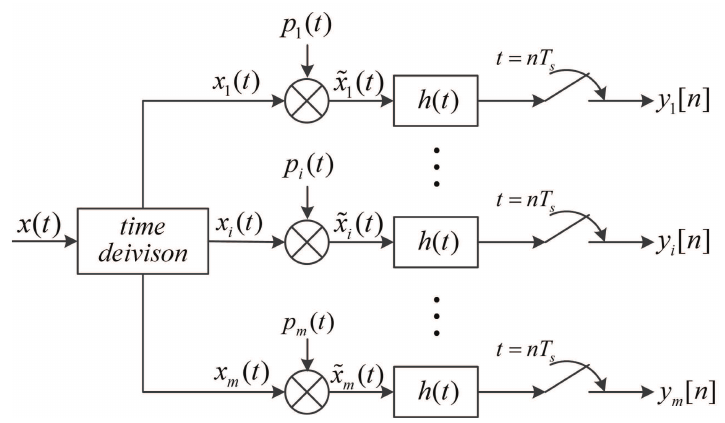
Figure 3. The equivalent of proposed single channel sub-Nyquist sampling